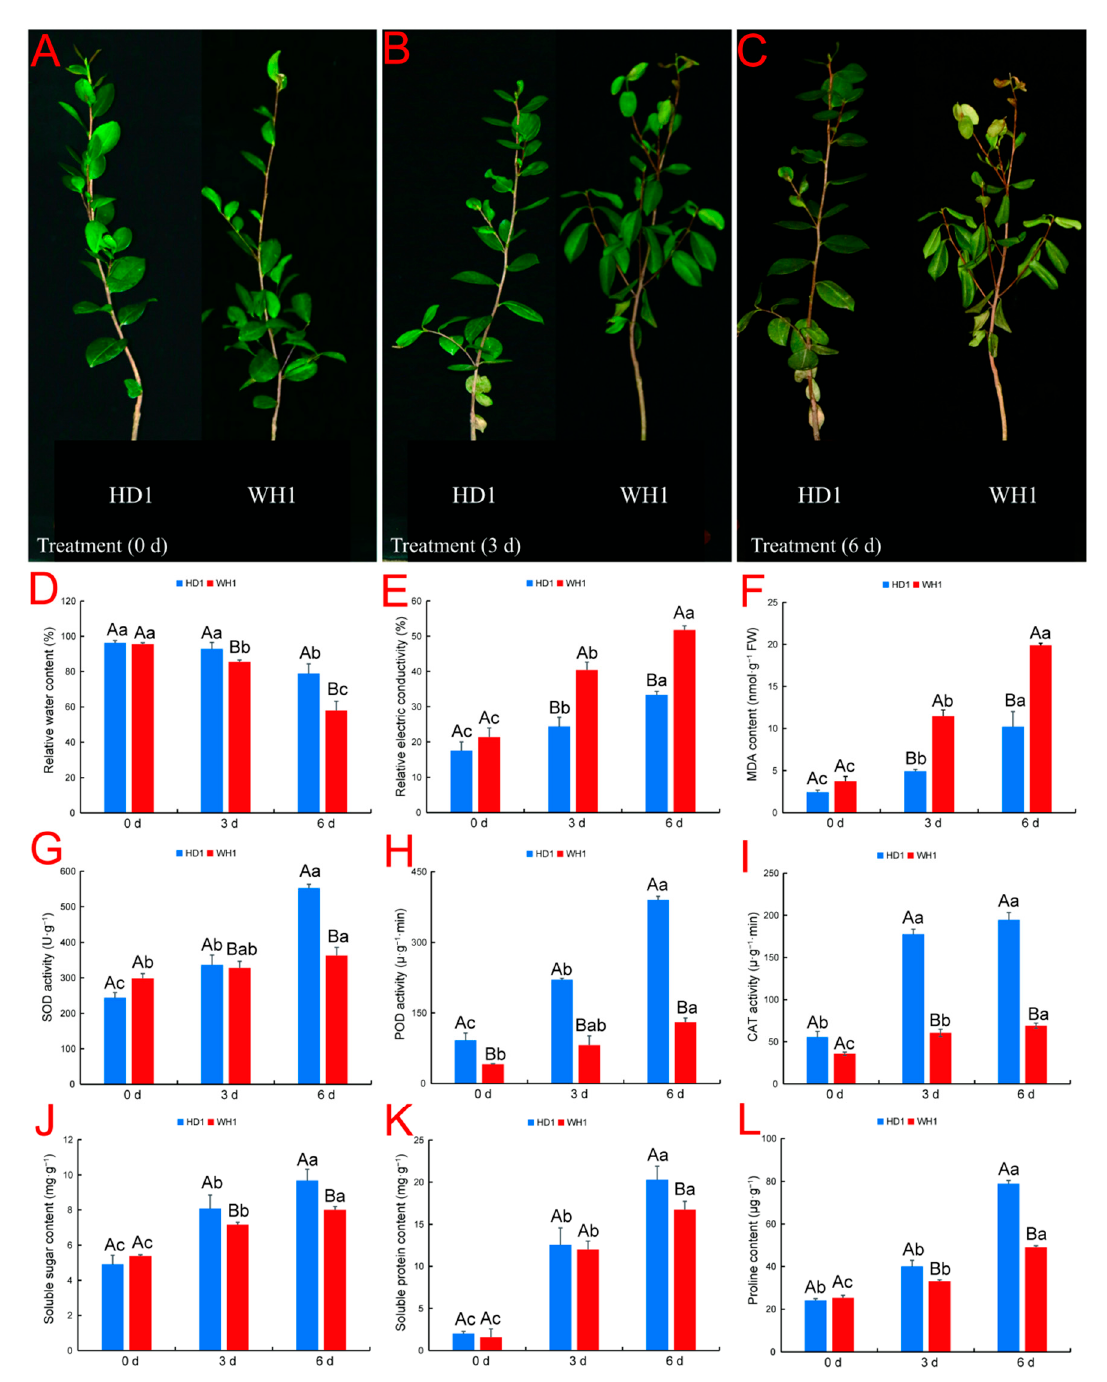
Figure 1. Phenotypic and physiological responses of drought-tolerant cultivar HD1 and drought- sensitive cultivar WH1. ( A ): Unstressed plants (0 d); ( B ): PEG stress treatment for three days (3 d); ( C ): PEG stress treatment for six days (6 d); ( D ): leaf relative water content; ( E ): relative electric conductivity; ( F ): MDA content; ( G ): superoxide dismutase (SOD) activity; ( H ): peroxidase (POD) activity; ( I ): catalase (CAT) activity ( J ): soluble sugar (SS) content ( K ): soluble protein (SP) content ( L ): free proline (Pro) content. All data are shown as the mean standard error. Different capital letters represent significant differences between cultivars; different lowercase letters indicate significant differences between treatments (Duncan’s test; p < 0.05).